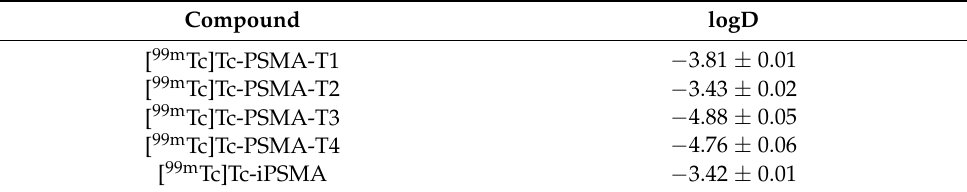
Table 3. Binding, internalization, and cell uptake of PSMA